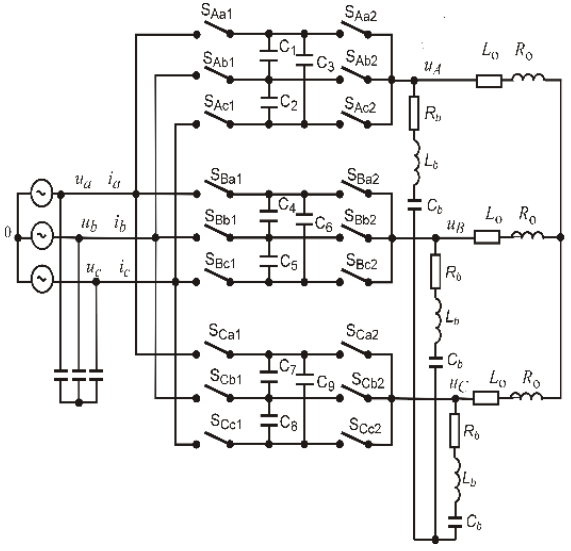
Figure 1. Scheme of multilevel matrix converter (MMC).